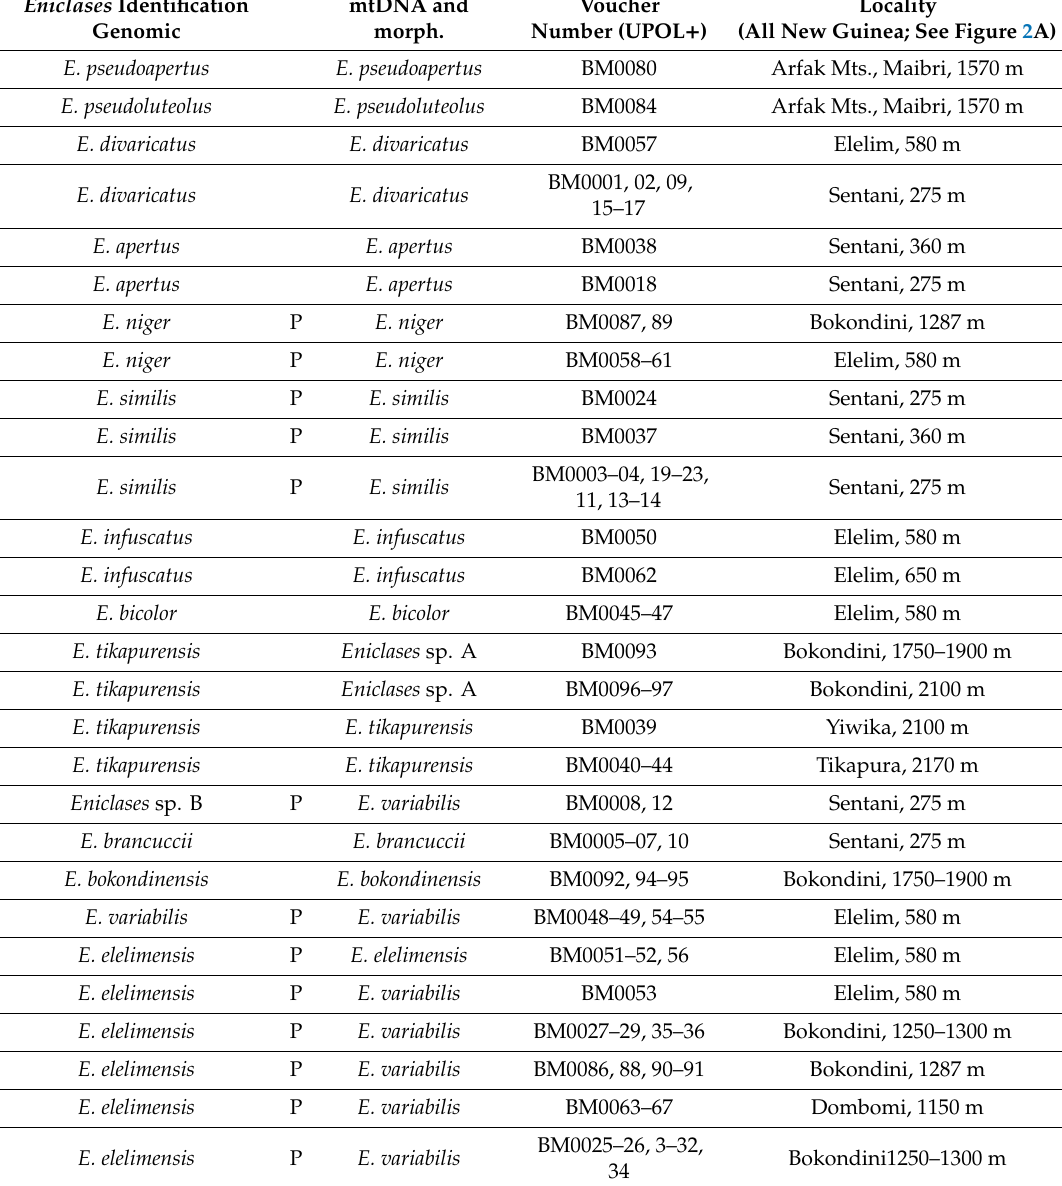
Table 1. The list of species, their geographic origins, collecting circumstances and aposematic patterns localities. Individuals with incongruent species placement in mtDNA and restriction site associated DNA analyses; P Individuals belonging to a polymorphic species based on the restriction site associated DNA